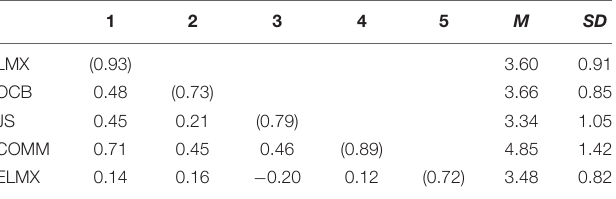
TABLE 6 | Correlations, alphas, means, and standard